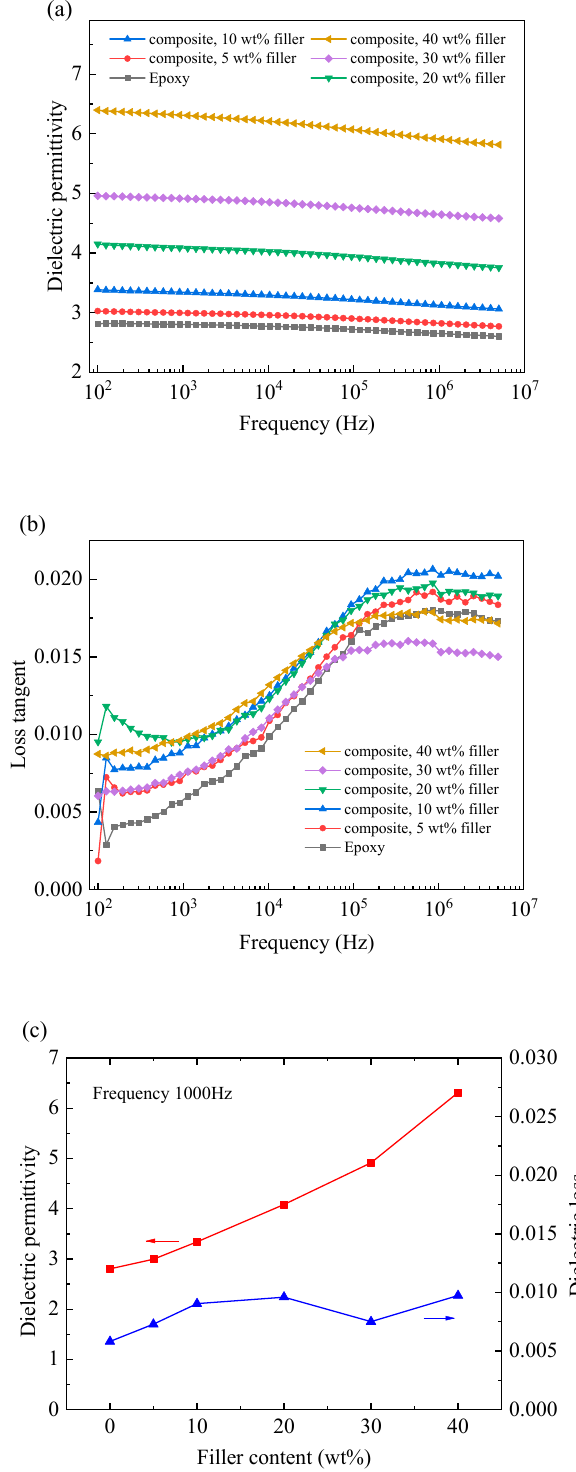
Figure 7. Frequency dependence of ( a ) dielectric permittivity and ( b ) dielectric loss of HF-Ti 3 C 2 T x / epoxy composites, and ( c ) variation of dielectric properties with the filler content at 10 3 Hz.